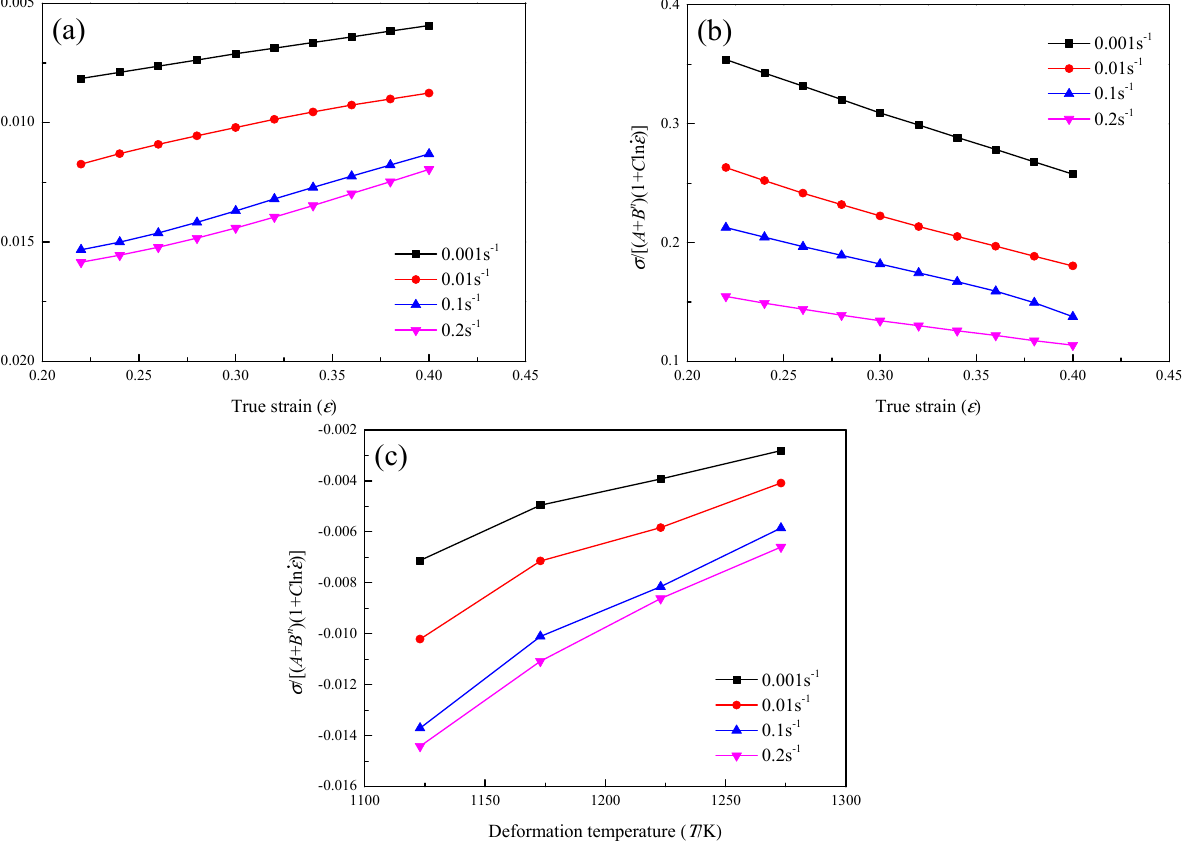
. (cid:2) ( (cid:0) (cid:1)(cid:3) − A + B ε n ) ε ε , 1 + C ln